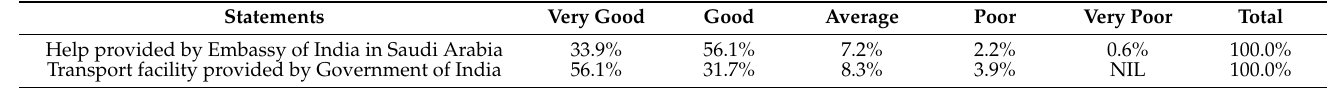
Table 6. Migrant’s perceptions towards COVID management by Government of